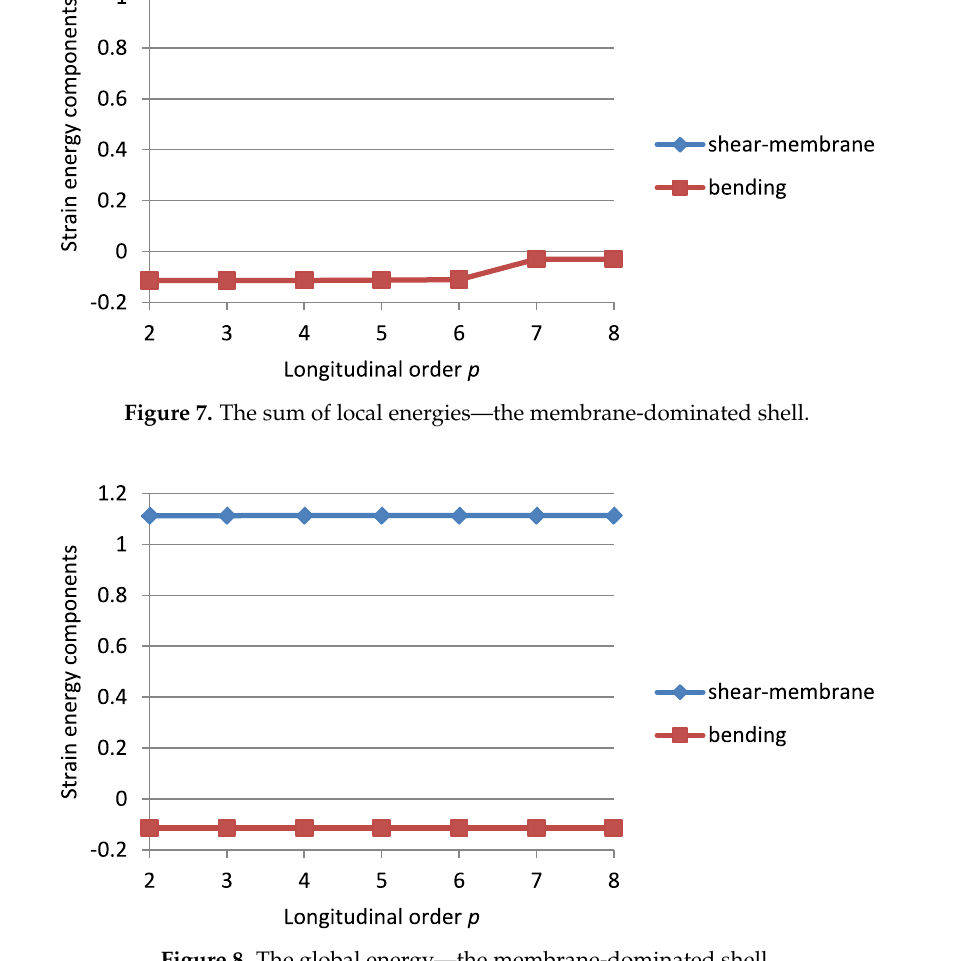
Figure 8. The global energy—the membrane-dominated